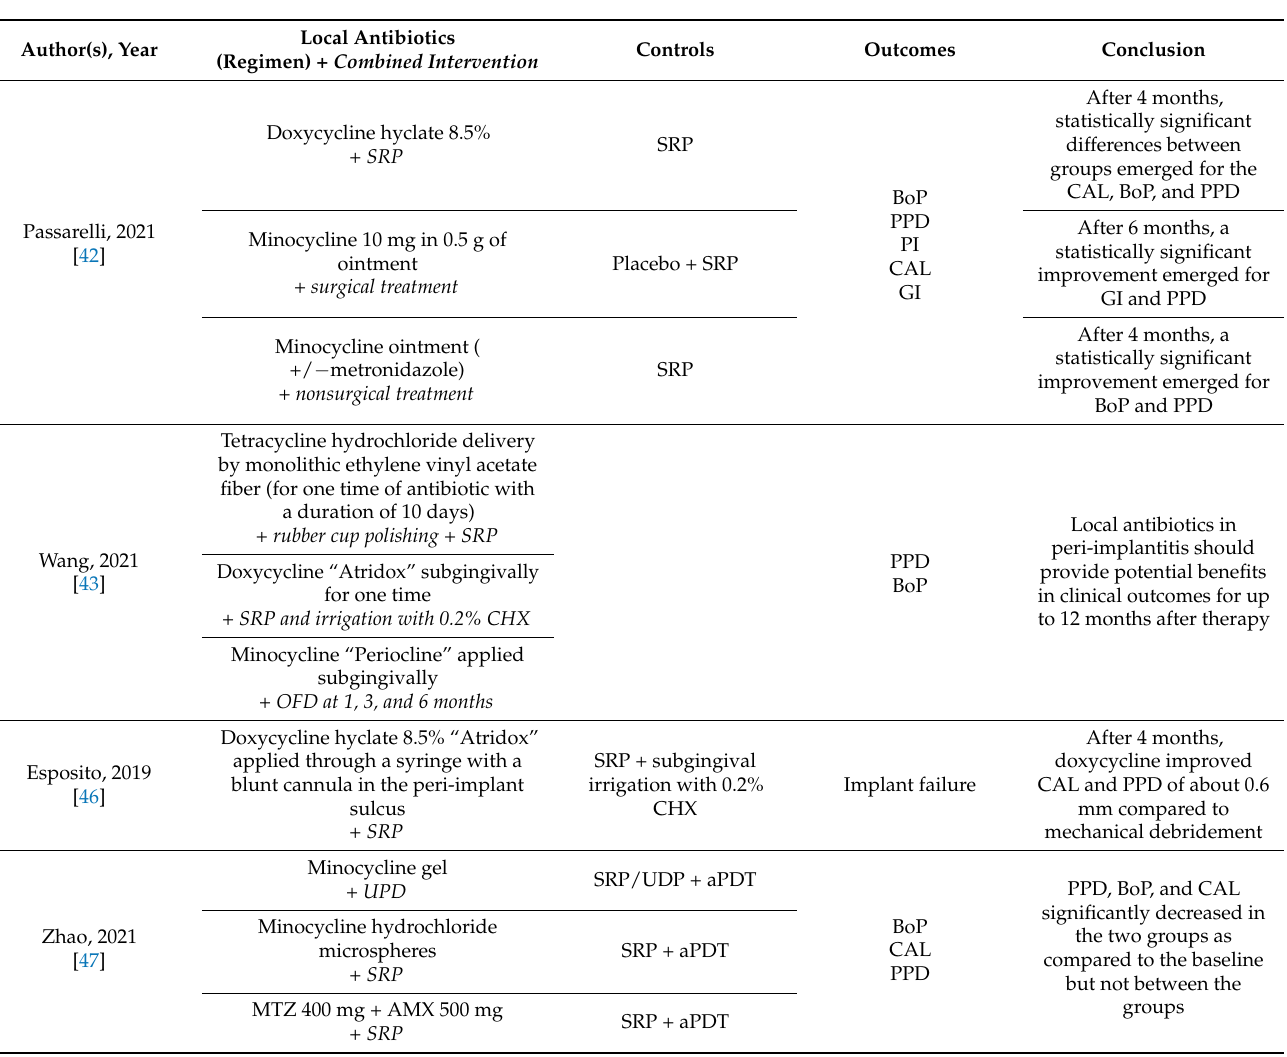
Table 5. Characteristics of locally-delivered antibiotics combined with other interventions in treating